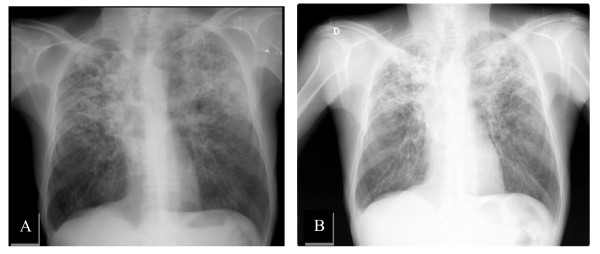
Chest X-ray on admission (A). Chest X-ray 8 months later, showing exsudative lesions on both upper lobes (B).